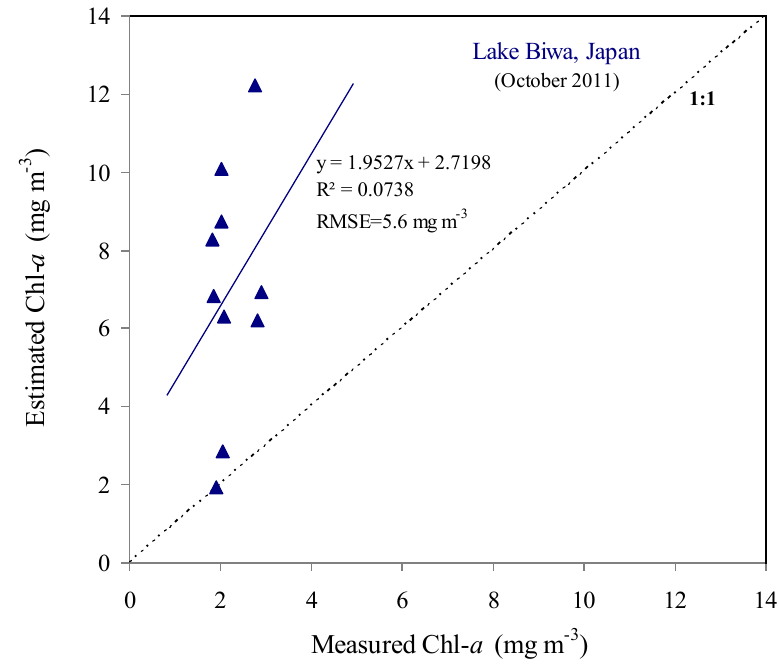
Figure 7. Comparison of the measured and estimated Chl- a by the SAMO-LUT for Lake Biwa, Japan.